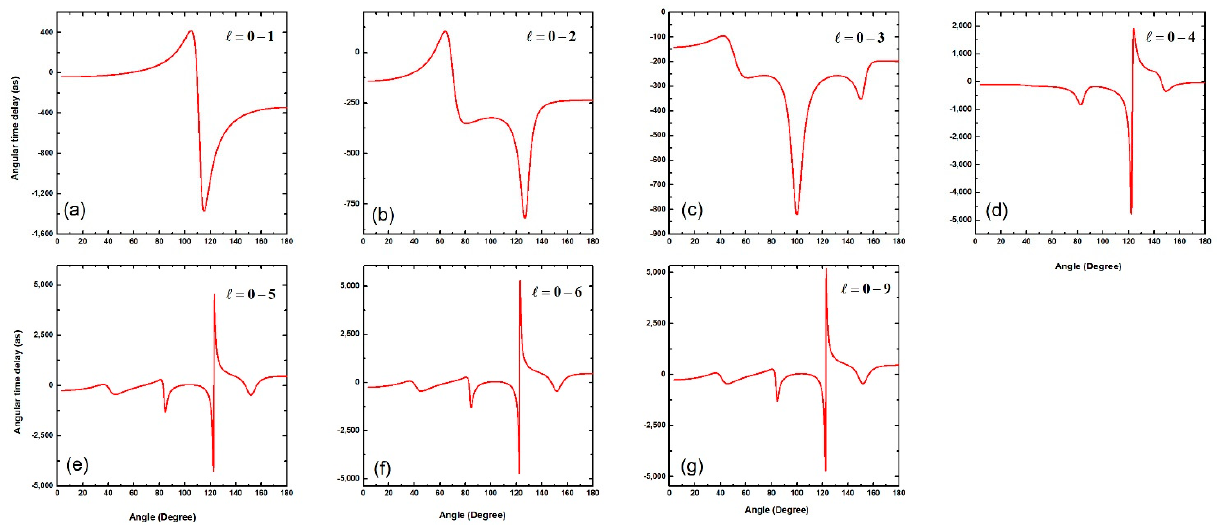
Figure 15. Angular time delay at the energy E 3 = 0.1360 a.u. plotted for different partial wave combinations ( a ) (cid:96) = 0–1, ( b ) (cid:96) = 0–2, ( c ) (cid:96) = 0–3, ( d ) (cid:96) = 0–4, ( e ) (cid:96) = 0–5, ( f ) (cid:96) = 0–6 and ( g ) (cid:96) =